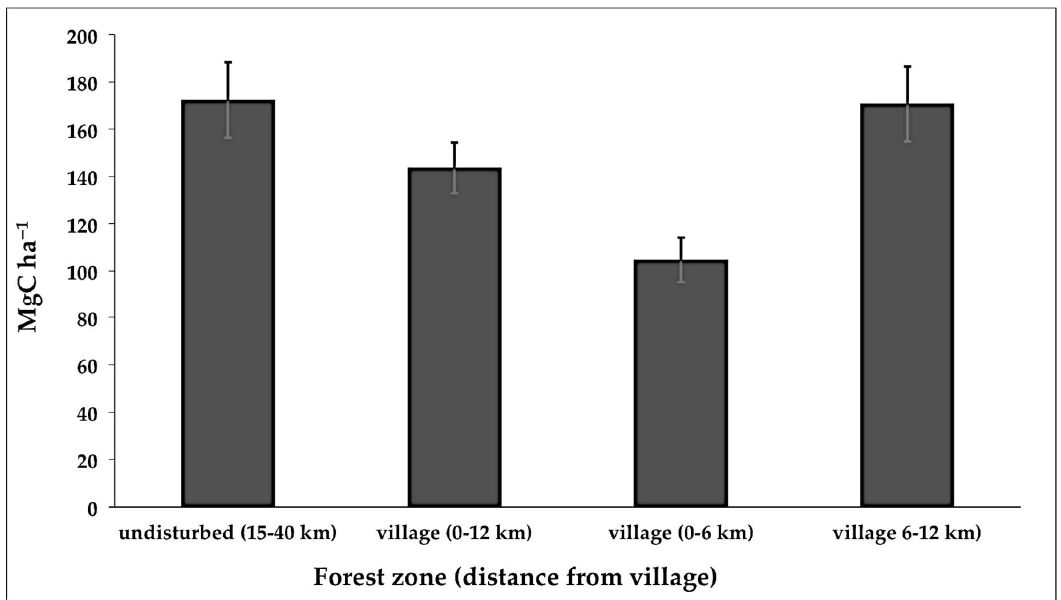
Figure 2. Estimates of mean aboveground carbon density in forests without human activities (‘undisturbed’), compared to mature forests around 15 indigenous villages in southern Guyana. Mature forests within a 12 km radius of the villages contained on average 17% less carbon per hectare than Undisturbed forest (143.6 MgC.ha −1 , se = 10.8, n = 386 plots, p -value = 0.002). Further analysis revealed that the carbon impact is restricted to within a 6 km radius from villages, since the mean carbon density of forests that were located 6–12 km from village centers was statistically not different from that of more distant Undisturbed forest (170.5 vs. 172.4 MgC.ha −1 , se = 15.9, n = 228